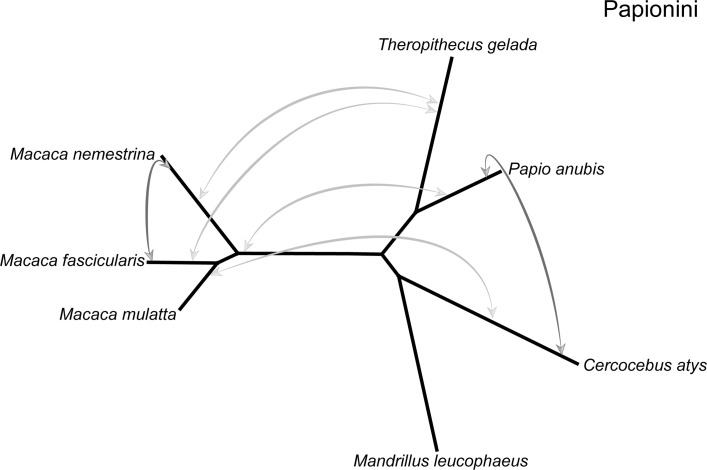
Introgression among Papionini taxa (the species tree is unrooted for clarity).Arrows indicate that a significant Δ was found in our 4 taxon tests and identify the 2 lineages inferred to have exchanged genes (values underlying these tests are listed in S8 Table). Among the Papionini, there was evidence of introgression between African taxa (Papio, Theropithecus, and Cercocebus) and Asian Macaca species (light gray arrows). Introgression events likely occurred between African taxa and the ancestral Macaca, which had a wide distribution across Northern Africa prior to the radiation throughout Asia 2–3 mya [103]. More recent instances of introgression are inferred between macaque species and among the African Papionini (dark gray arrows). mya, million years ago.